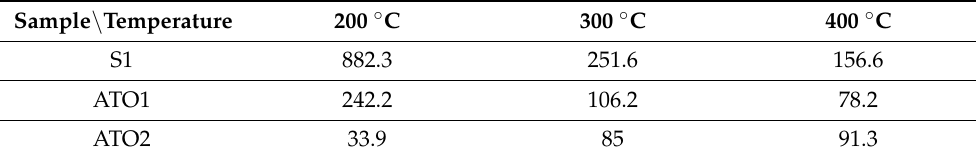
Table 4. Resistance (k Ω ) of samples at different working temperatures in dry air. Sample \